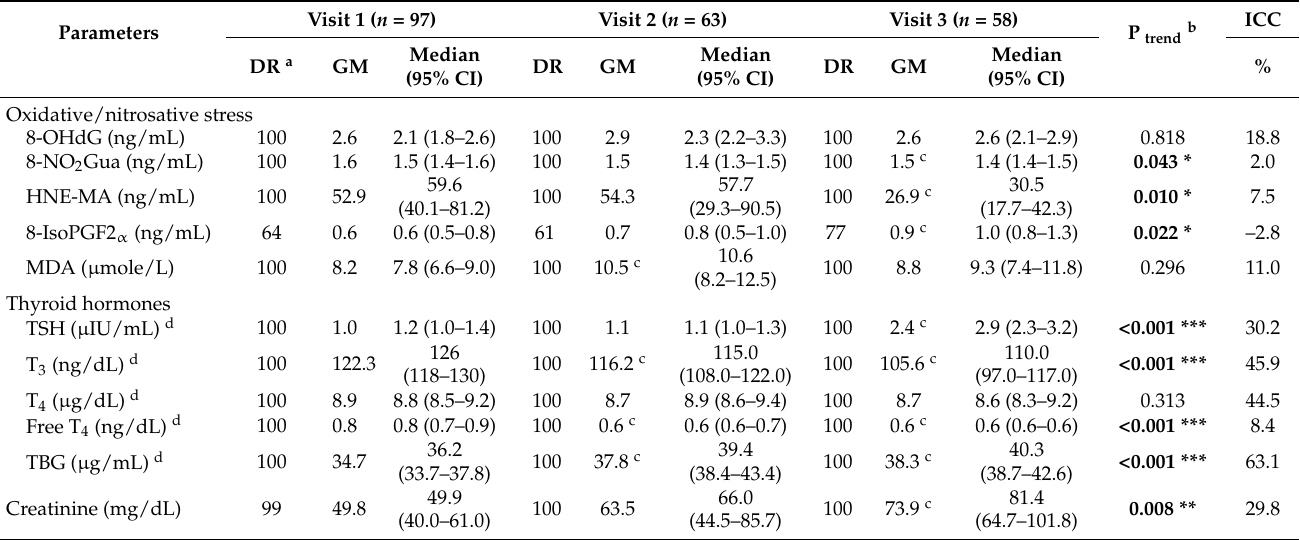
Table 2. Distribution of oxidative/nitrosative stress biomarkers, thyroid hormones, and creatinine in pregnant women by study visits (N = 218) a